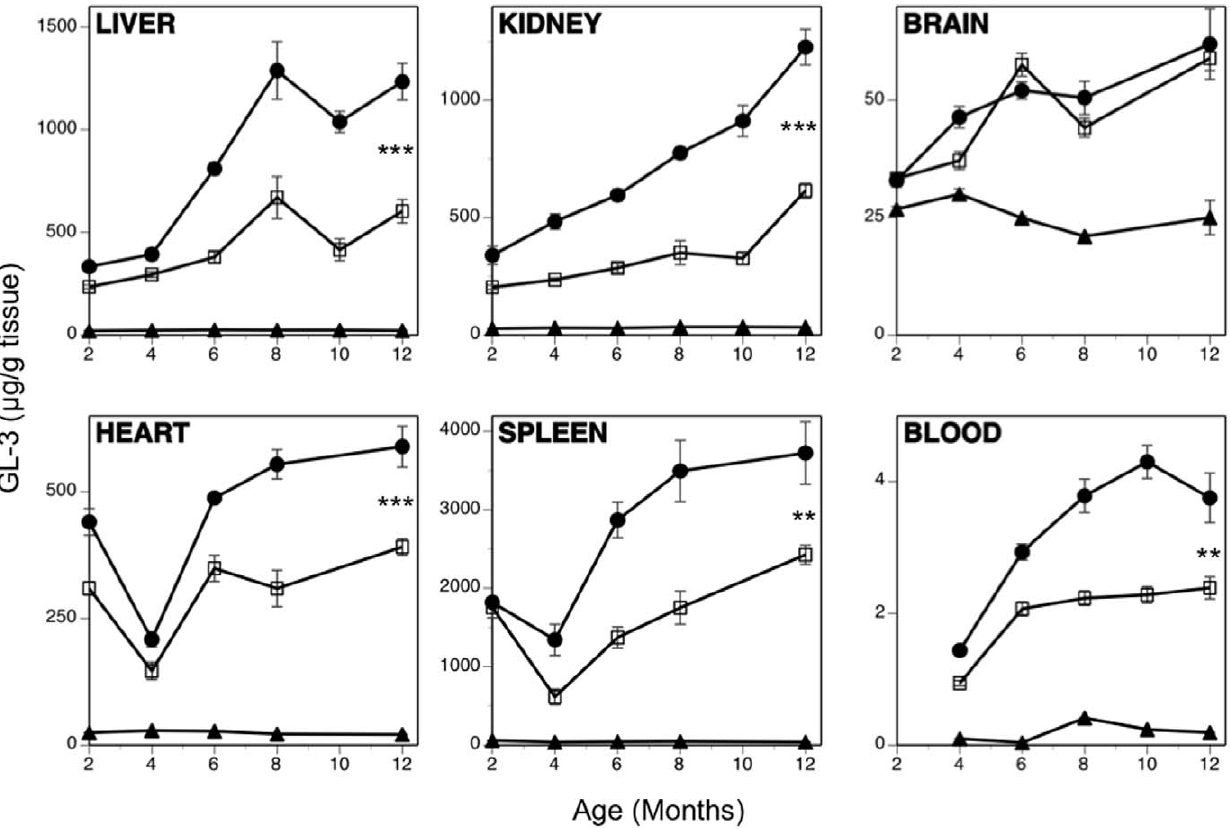
Figure 1. Substrate reduction therapy delays the accumulation of GL-3 in visceral tissues of Fabry mice. Treated Fabry mice received eliglustat tartrate as a component of their food beginning at 5 weeks of age. The GL-3 levels in various tissues of untreated control Fabry ( tartrate-treated Fabry ( % ) andwild-type mice ( m ) were determined using a mass spectrometry assay and arepresented as m g GL-3/g wet tissue. Data are shown as mean 6 SEM (n=5 mice/time point). Statistics were performed using the Graphpad Prism software t test (**=p , 0.01; ***=p , 0.001).